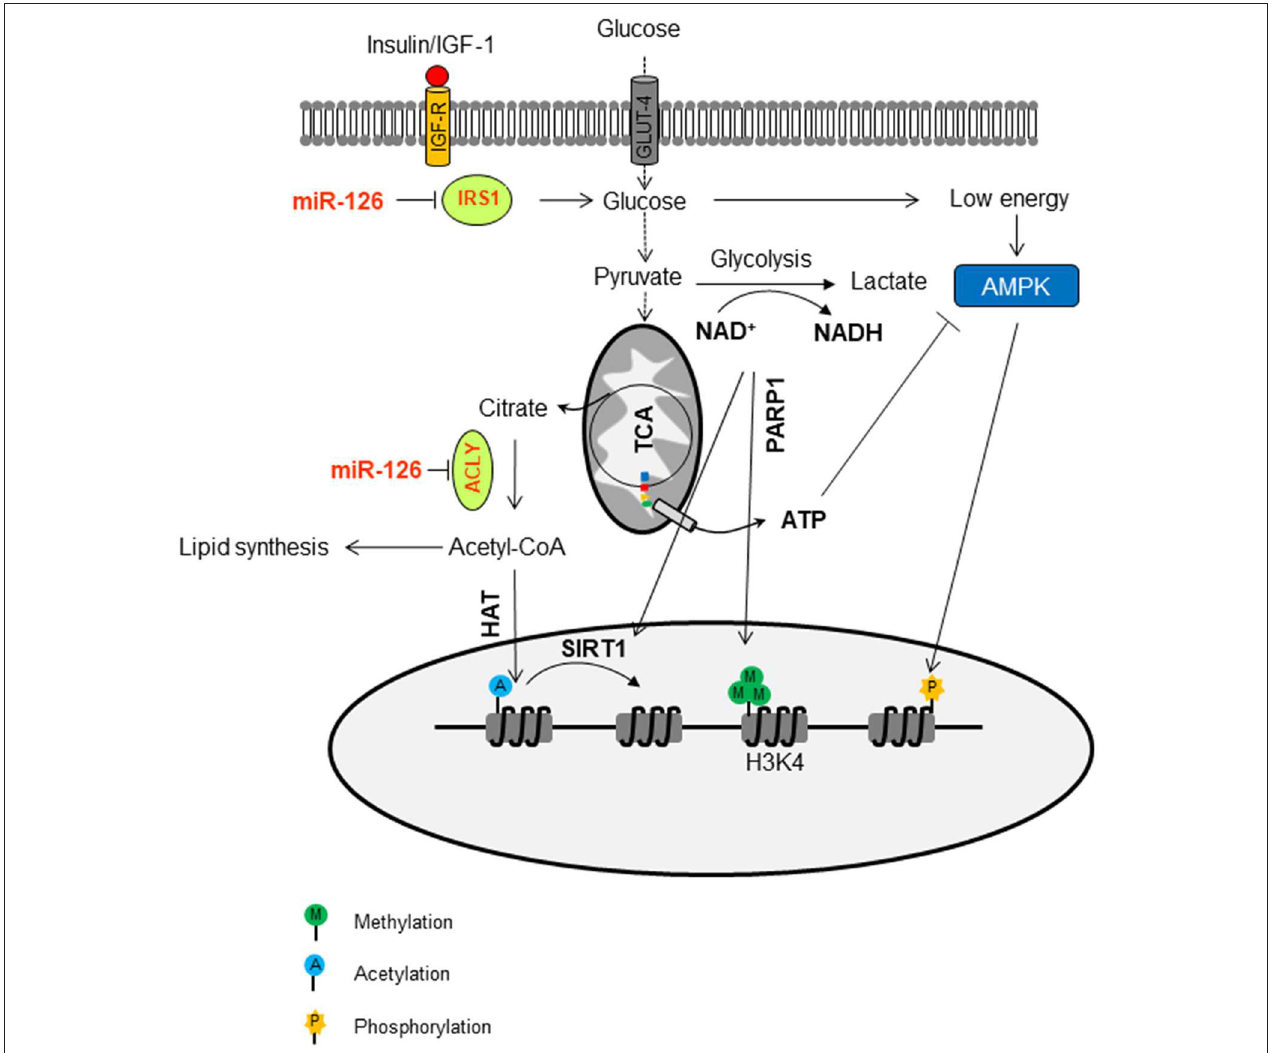
FIGURE 3 | Epigenetic regulation of miR-126 by metabolic changes in malignant mesothelioma. MiR-126 suppresses IRS1 by binding to its 3 ′ -UTR, with ensuing inhibition of the insulin/IGF-1/AKT pathway. This contributes to the change of glucose metabolism. The flux trough glycolysis determines the NAD + /NADH ratio, which is involved in the activation of sirtuin histone deacetylases (SIRTs). The NAD + -dependent PARP1 is involved in the maintenance of H3K4me3 in the trimethylation form, a marker of permissive chromatin. The ATP/AMP ratio can activate AMPK, a kinase that can phosphorylate histones. In addition, miR-126 inhibits ATP citrate lyase (ACLY), thus increasing the cytosolic citrate, which is converted to acetyl-CoA and used as a donor for histone acetyltransferases (HAT)-mediated histone